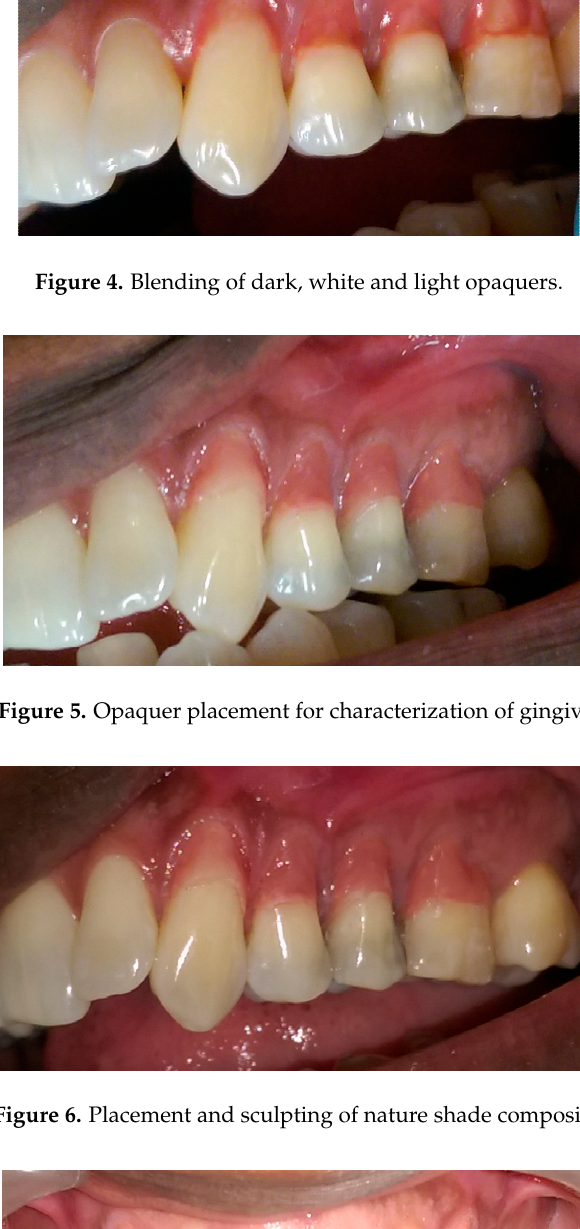
Figure 2. Initial placement of the dark opaque.